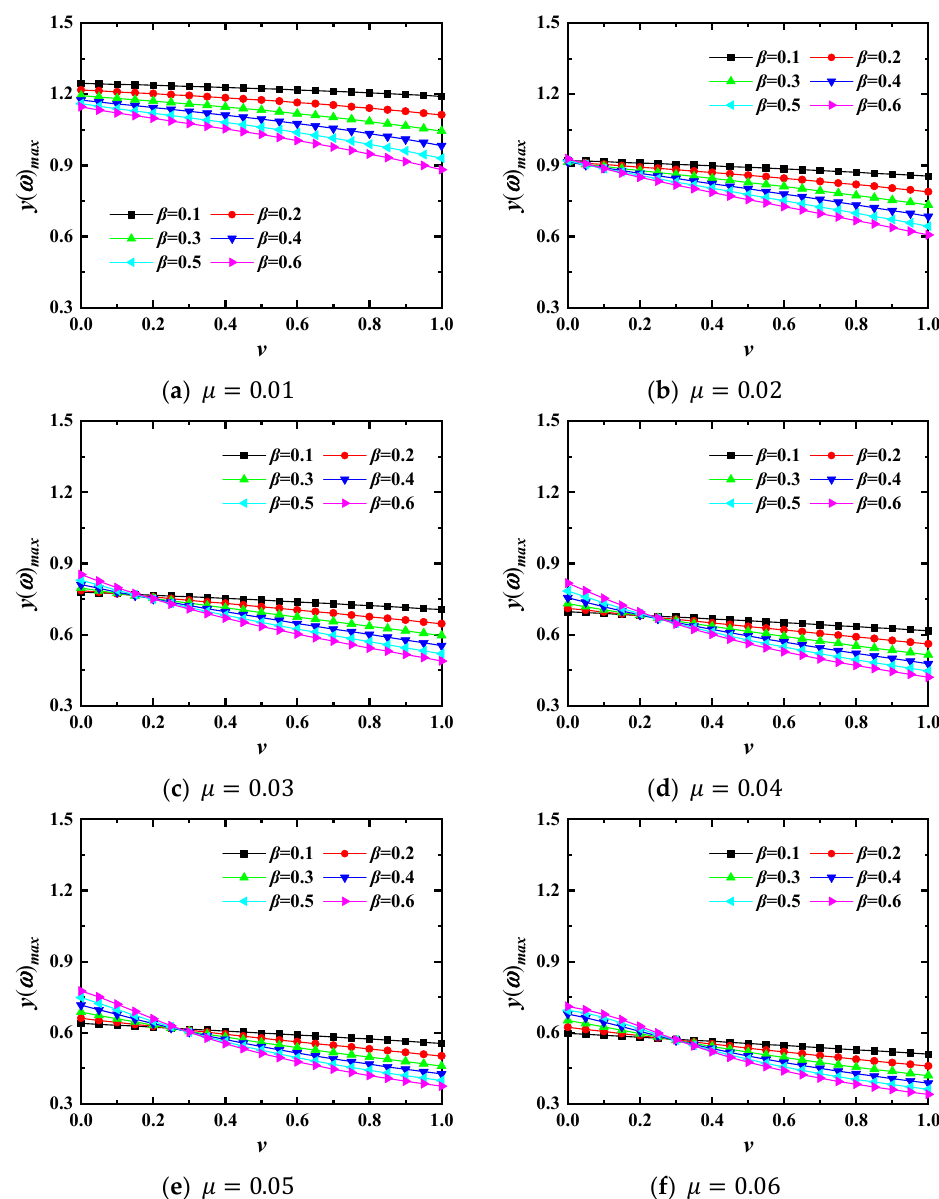
Figure 7. The peak value of displacement response versus suspension location factor with different mass ratios and apparent mass ratios.